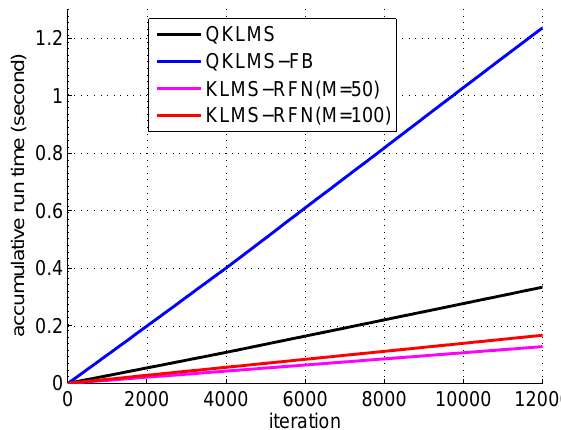
Figure 14. The run time curves of the QKLMS, QKLMS-FB, and KLMS-RFN algorithms in channel equalization with an abrupt change in